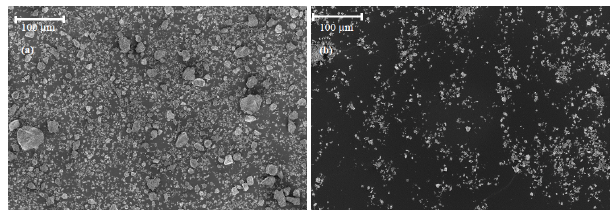
Figure A1. SEM images of two different quartz samples at 500 × magnification. (a) Quartz sample from Kaufmann et al. (2016);